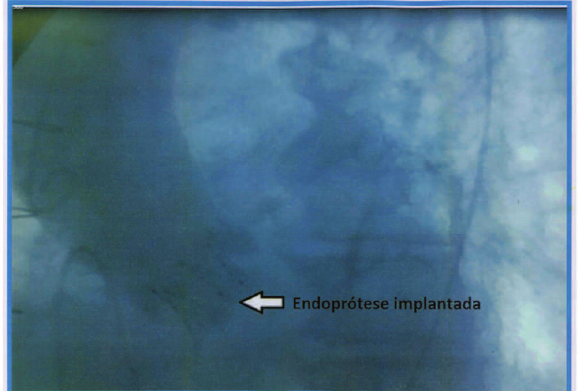
Fig. 2 - Imagem da fluoroscopia demonstrando a ausência de refluxo transvalvar aórtico e o posicionamento da prótese valvar aórtica após o implante transcateter por via transfemoral. Nota- se, também, a manutenção da perfusão pelo tronco coronariano